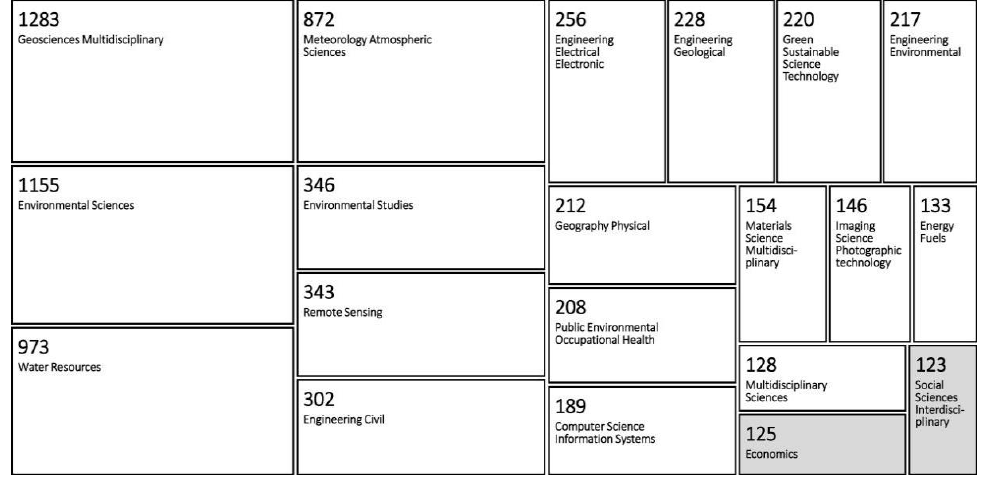
Figure 2. The number of articles in different fields of disaster studies in China from 2011 to 2020 (Data source: Web of Science, Access date: 14 October 2021).